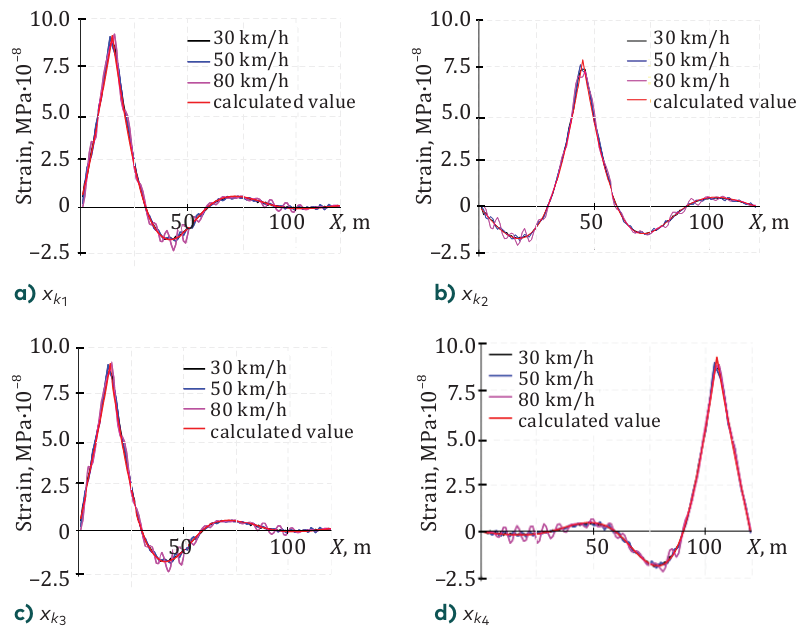
Figure 7. Calculated theoretical strain influence lines based on the proposed